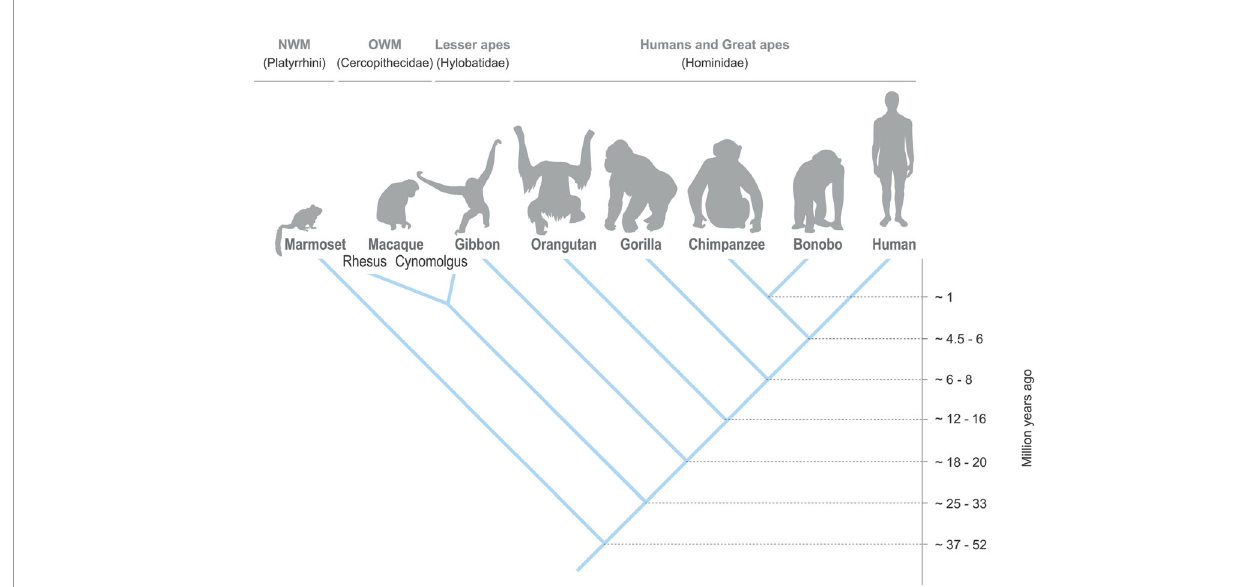
FIGURE 4 | Evolutionary relationship between the different primate